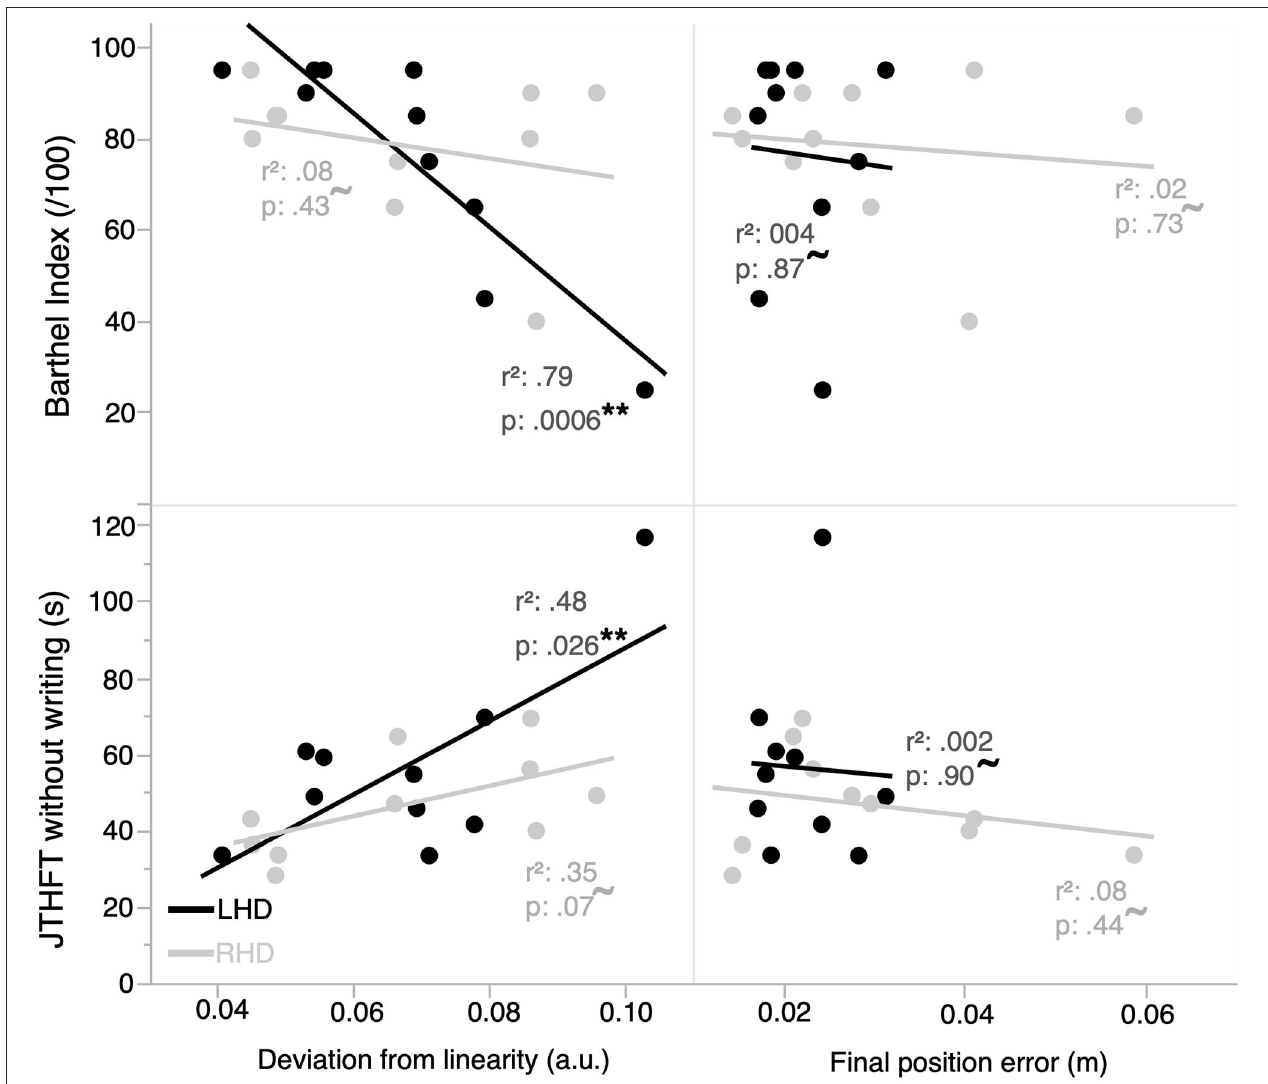
FIGURE 4 | Functional independence and ipsilesional arm motor performance are correlated with kinematic measures of performance in the ipsilesional arm. Functional independence and motor performance in the LHD group ( n = 10) are better correlated with an ipsilesional arm optimal trajectory control vs. impedance control measure of hand kinematic performance. The RHD group ( n = 10) does not have a statistically significant linear relation between any of the kinematic measures and functional independence/ipsilesional motor performance. **represents statistically significant correlations; ∼ represents correlations that are not statistically